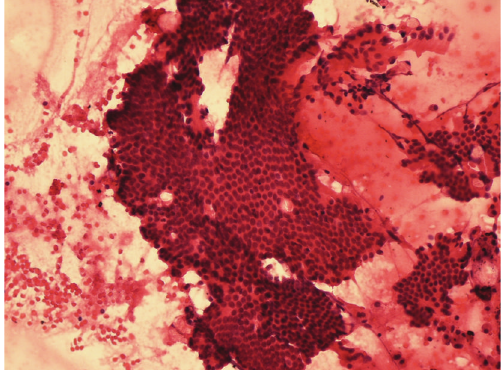
Figure 4: Progesterone staining of the surgical